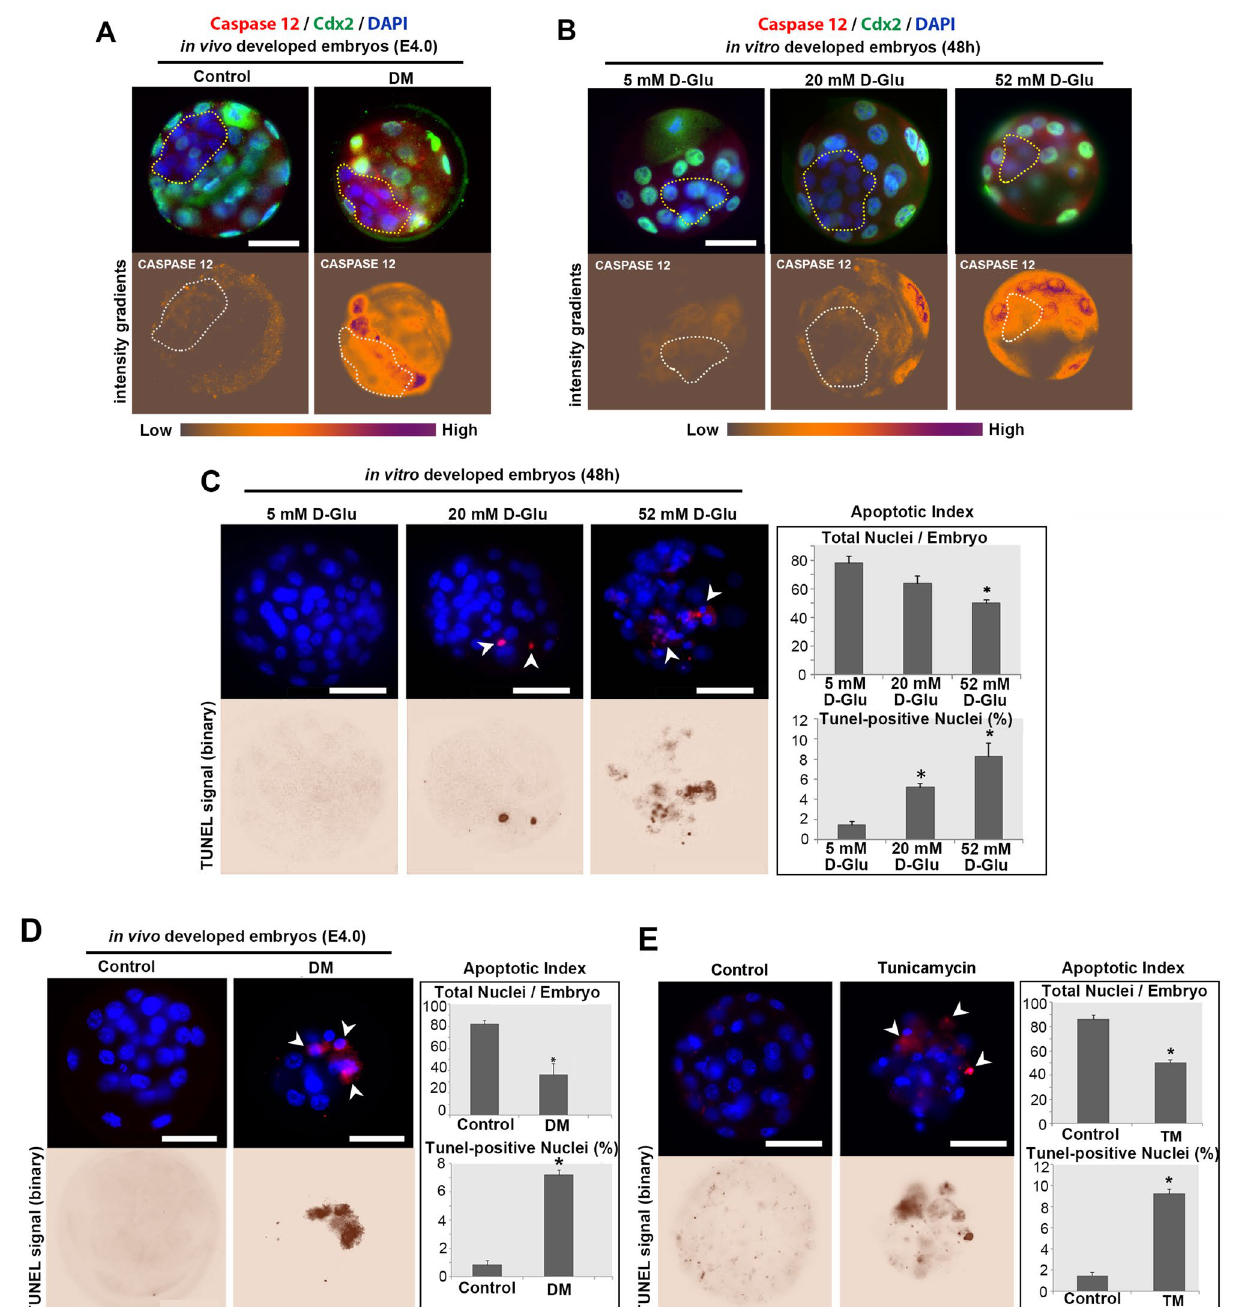
Figure 6. Cell death assessment in blastocysts developed in hyperglycaemic conditions in vitro and in vivo. (A,B) The expression of Caspase 12 protein at 4 days after fertilisation in vivo (A) ; and in blastocyst stage embryos (at 48 h in vitro culture) in 5 mM (physiological), 20 mM and 52 mM D-Glucose exposed experimental groups (B) . Red fluorescent, Caspase 12; green fluorescent TE layer marker Cdx2; blue fluorescent, nuclear DAPI labelling. Images below show Caspase 12 expression as an intensity gradient map. Yellow and white dashed lines demarcate ICM. Scale bars = 50 µm. At least 5 embryos analysed per group. ( C,D) Cell death rates and nuclear cell counts were determined in the blastocysts exposed to hyperglycaemic conditions in vitro (B) and in vivo (C) by the TUNEL assay. Red fluorescent, TUNEL marking that binds to DNA fractures; blue shows the DAPI staining bound to fluorescent nuclear content. White arrows show TUNEL-positive nuclear fragments; binary images below highlight TUNEL signal. Scale bars = 50 µm. One-way ANOVA followed by TUKEY’s multiple comparisons test, * P < 0.05 . n = 10 per group. All experiments were performed in triplicate. Columns are means ± SD. ( E) Cell death rates and nuclear cell counts in control (n = 10) and Tunicamycin (TM)- treated (n = 5) embryos. Red fluorescent, TUNEL marking that binds to DNA fractures; blue shows the DAPI staining bound to fluorescent nuclear content. White arrows show TUNEL-positive nuclear fragments; binary images below highlight TUNEL signal. Student’s t test, * P < 0.05 . n = 10 per group. Columns are means ±